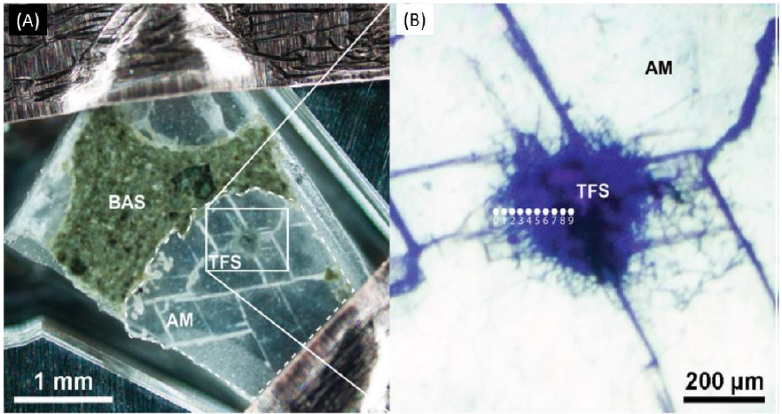
Figure 3. Optical images showing the ( A ) entire sample including the host basalt (BAS), the amygdale (AM) and the tangle of filamentous structures (TFS) and ( B ) placement and numbering of the points investigated by LMS in the dark inclusion resembling a TFS [80].